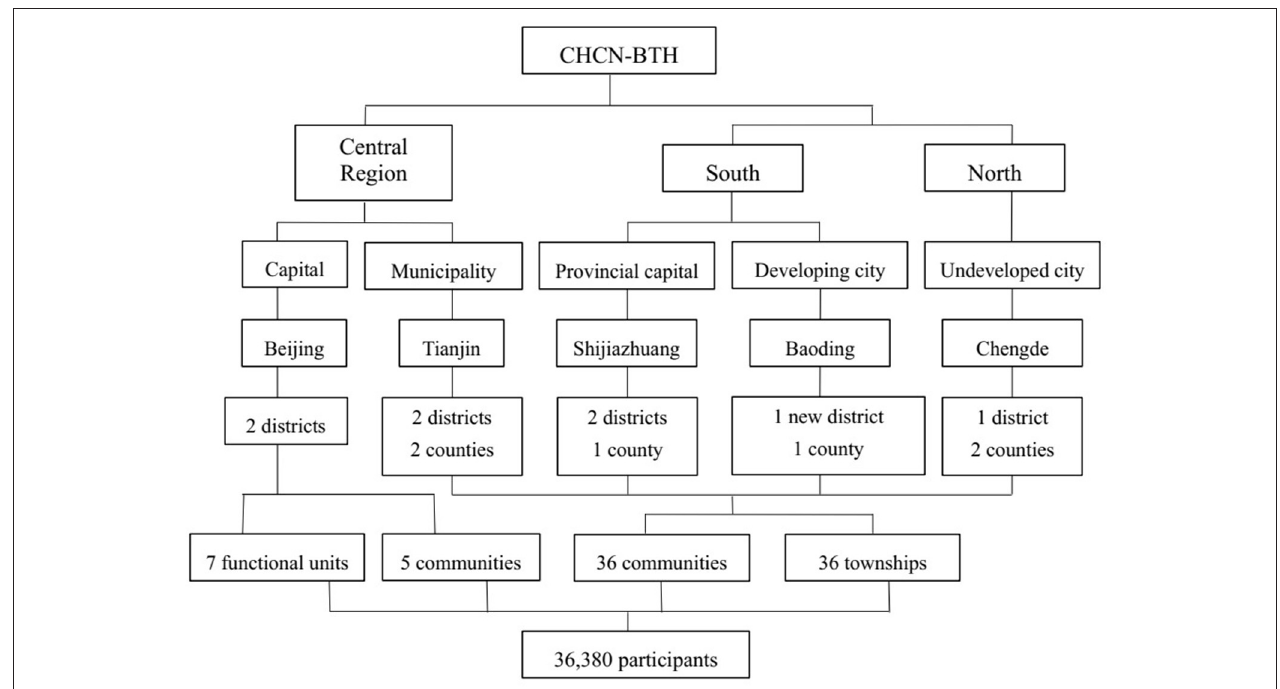
FIGURE 2 | Sampling flowchart of